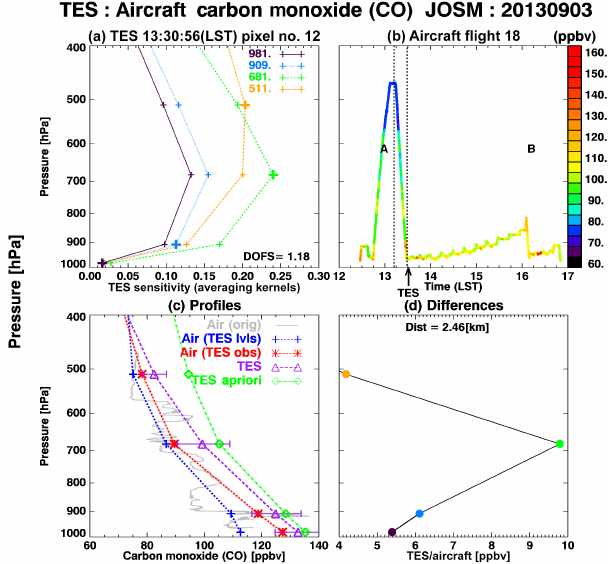
Figure 5. Representative single CO profile aircraft/satellite compar- ison and associated plots. Plotted is the downward aircraft spiral of profile “A” compared with pixel 12 along the TES transect. Plotting convention is the same as Fig. 3.